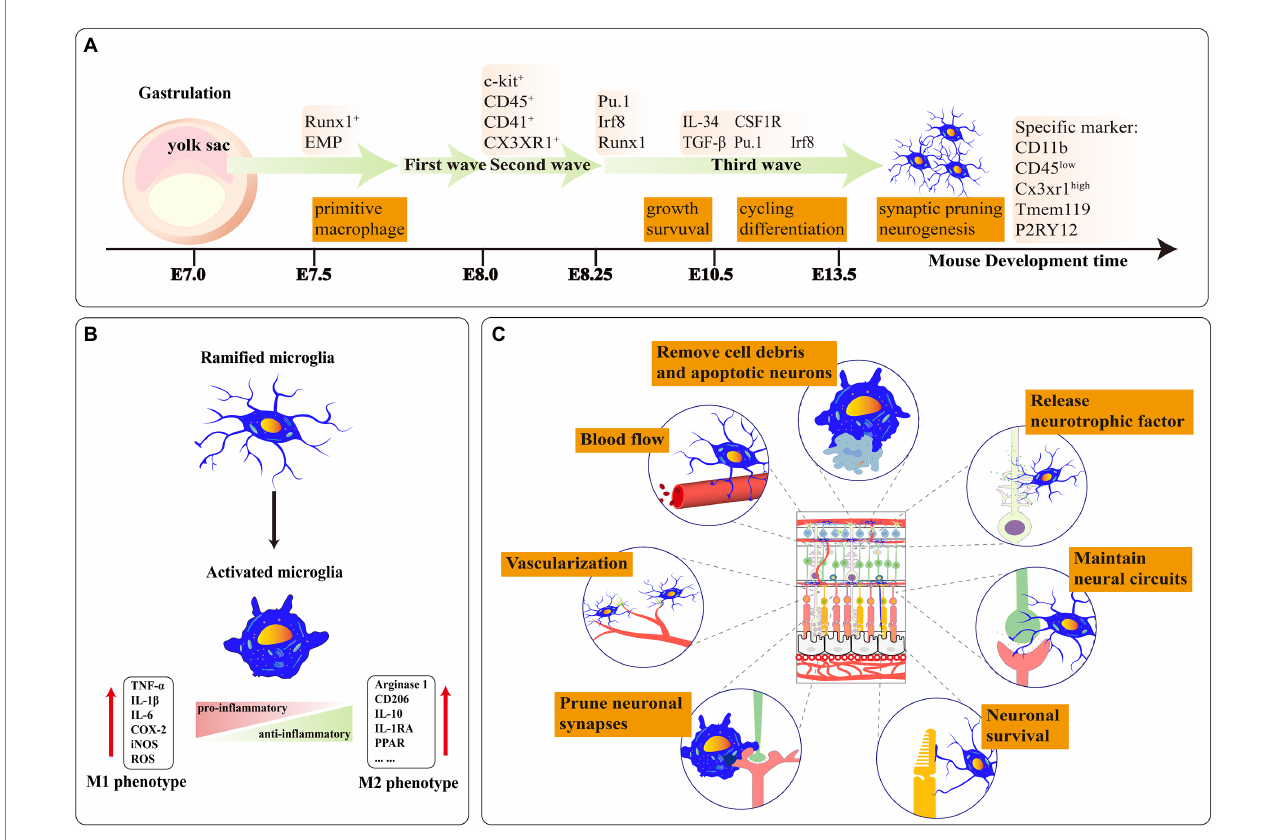
FIGURE 1 (A) A stepwise microglia developmental program in the retina. Mature microglia maintain a stable population derived from self-renewal. E-embryo. (B) Ramified microglia can be activated to two polarized phenotypes: M1 and M2. The polarization of M1 microglia increased the expression level of proinflammatory factors. Moreover, the polarization of M2 microglia expressed a high level of anti-inflammatory factors. (C) The functions of microglia in healthy retina tissue: Phagocytosis of apoptotic cells and debris; releasing neurotrophic factors to neurons; maintaining neural circuits; ensuring the survival of neurons; pruning neuronal synapses; promoting angiogenesis in retinal development; controlling the retinal vascular blood flow